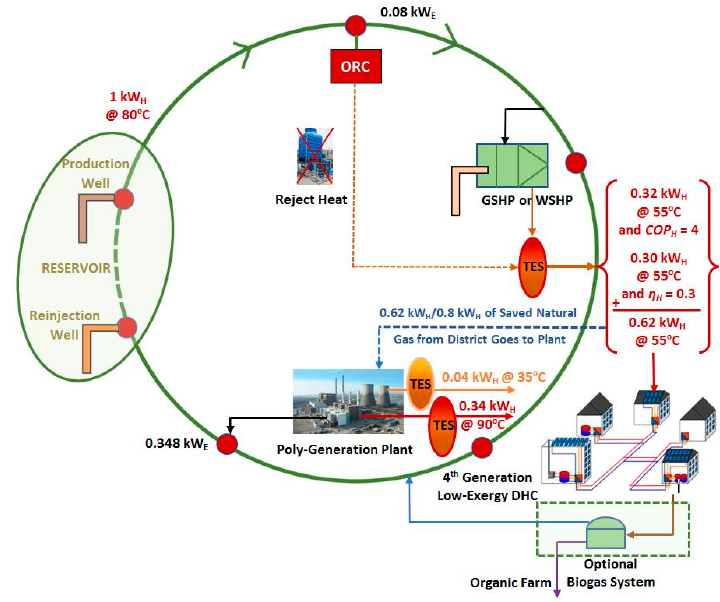
Figure 16. Combined Heat and Power in Circular Geothermal Model in Heating Mode.